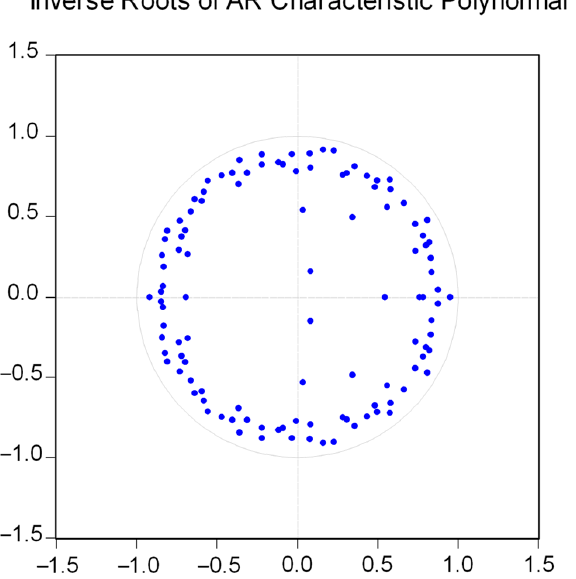
Figure A1. Stability test of the VAR Model. Note: All the inverse roots presented in the graph correspond to the panel VAR model with least squares, the model is stable with 16 lags. Source: Own Elaboration. Table A5. VAR Residual Serial Correlation LM Tests.